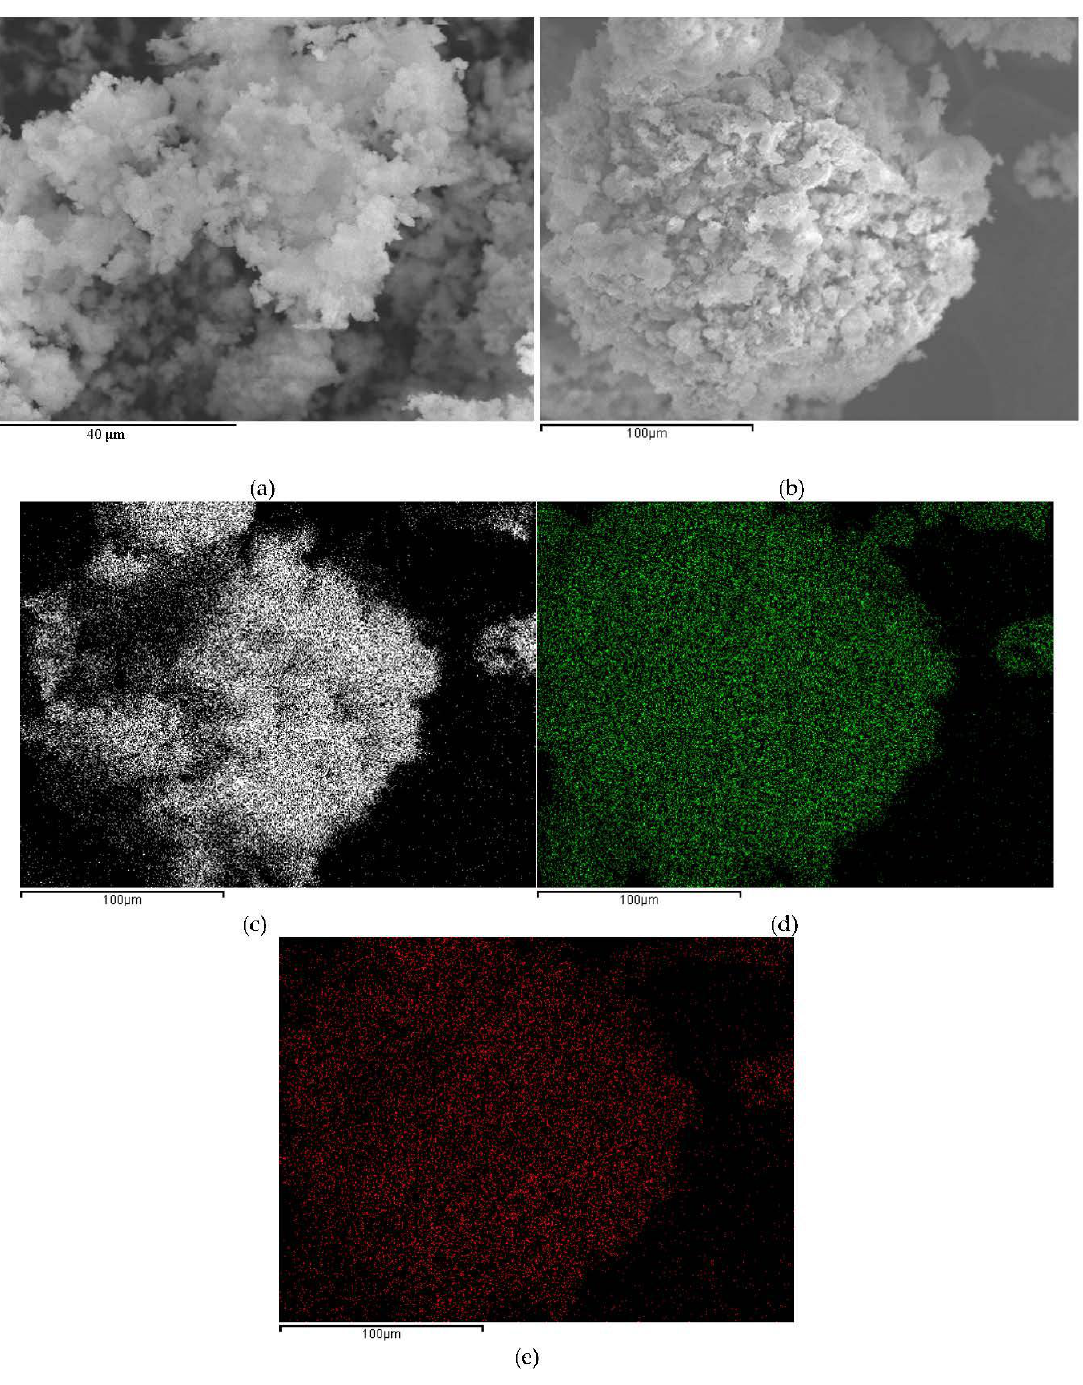
Figure 6. Scanning electron microscopy (SEM) images: ( a ) 5% TiO 2 -MAGSNC photocatalysts; ( b ) 2% TiO 2 -MAGSNC nanocomposites; and elements mapping of 2% TiO 2 -MAGSNC photocatalysts: ( c ) Si; ( d ) Fe; ( e ) Ti.